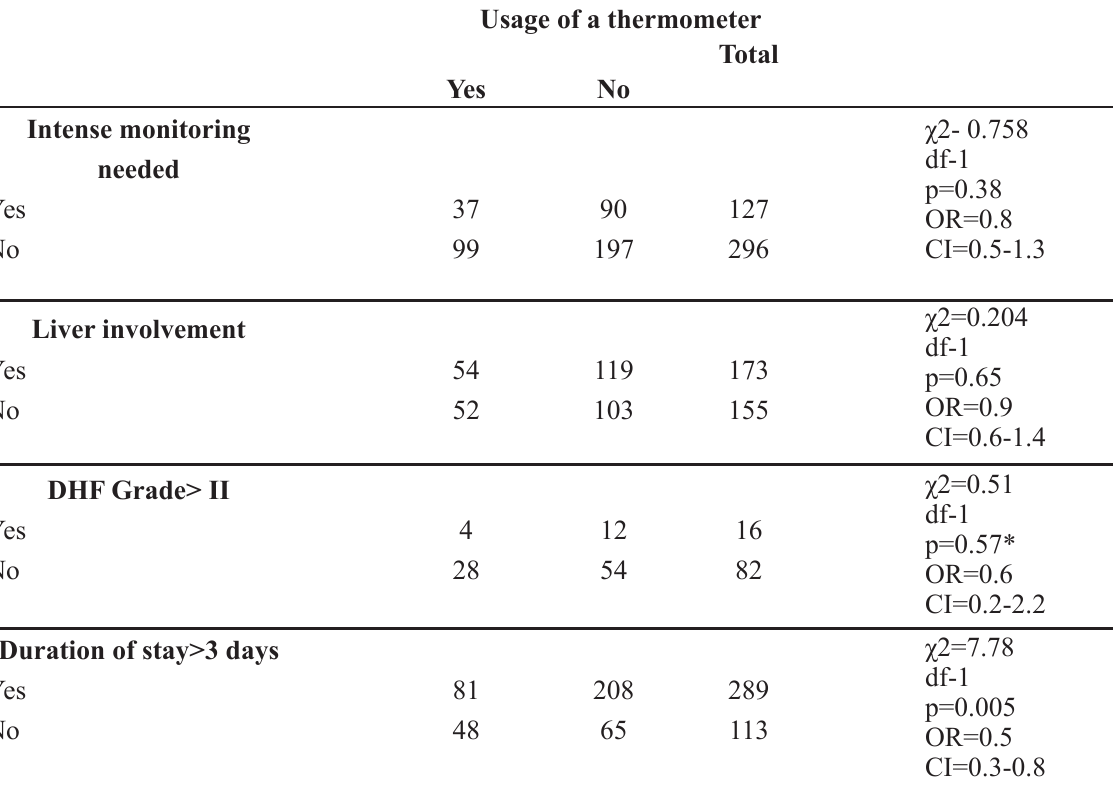
Table 3 Association between selected factors and need of intense